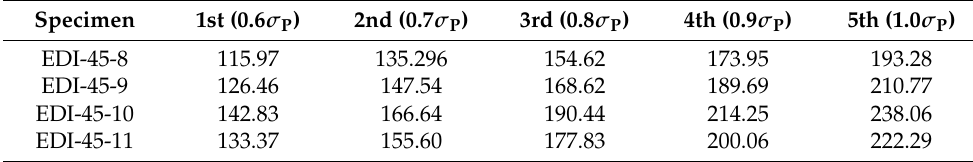
Table 2. Applied stress levels in creep